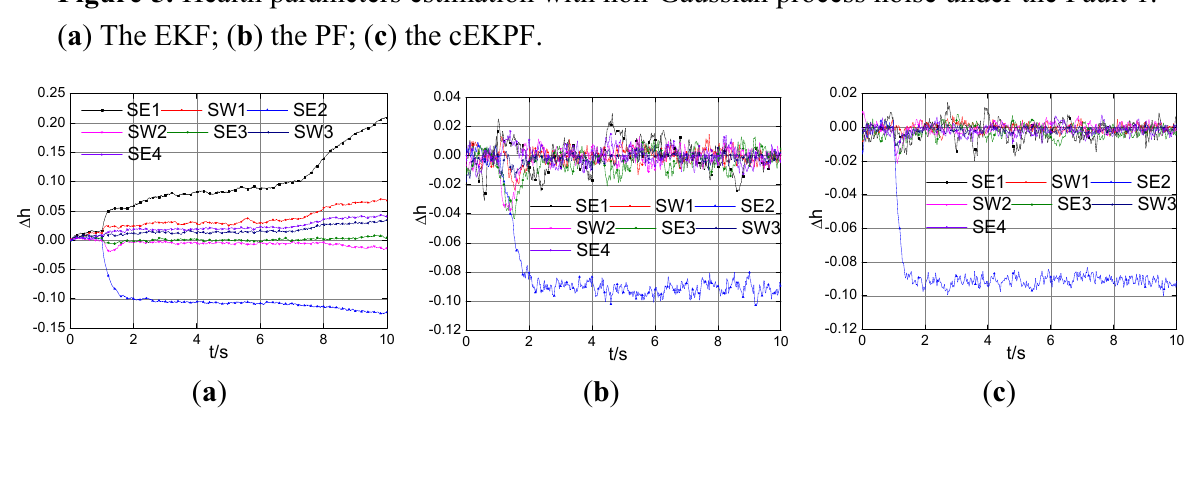
Figure 5. Health parameters estimation with non-Gaussian process noise under the Fault